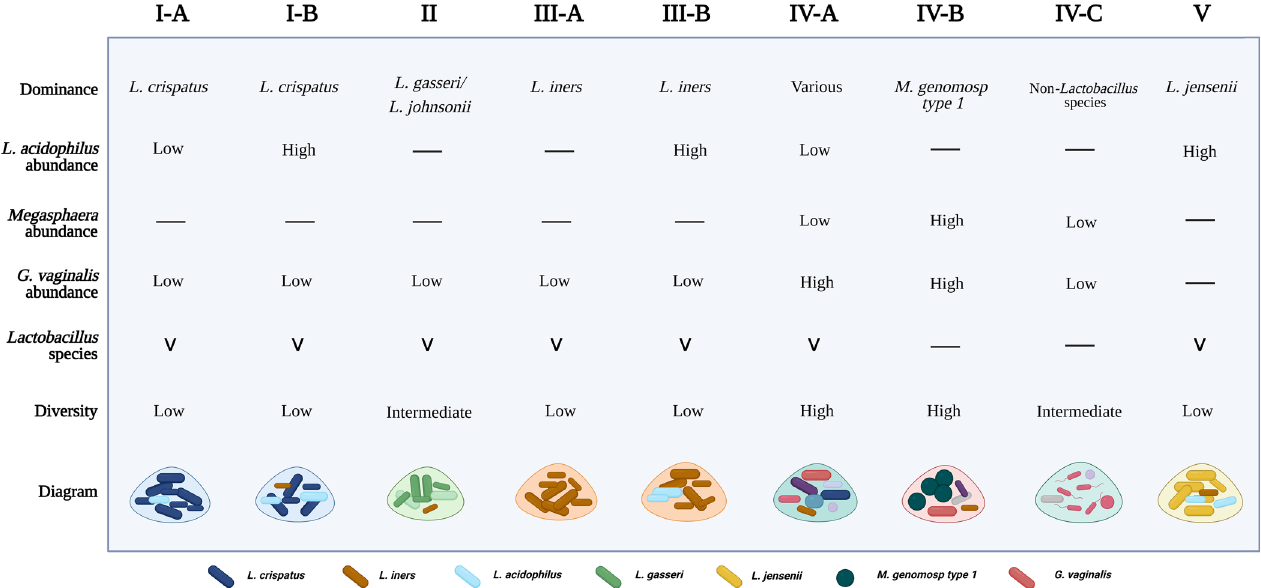
Fig. 4 Characteristics of novel cervicovaginal microbial community state types. CST I-A exhibits L. crispatus dominance, low abundance of L. acidophilus , and low diversity. CST I-B also possesses L. crispatus dominance but a higher abundance of L. acidophilus and L. iners . CST II retains L. gasseri/L. johnsonii dominance and has low diversity. CST III-A owns dominance for L. iners and shallow diversity. CST III-B is also characterized by L. iners dominance but includes L. acidophilus . CST IV-A displays dominance for various species, high abundance of G. vaginalis , and low abundance of M. genomosp type 1 . CST IV-B is characterized by dominance for M. genomosp type 1 , colonization by G. vaginalis , and Lactobacillus depletion (excluding L. iners ). CST IV-A and IV-B have a high diversity. CST IV-C is dominated by non- Lactobacillus species and exhibits Lactobacillus depletion with intermediate diversity. CST V has L. jensenii dominance, high abundance for L. acidophilus and L. iners , and overall low diversity. Presence of microbes is indicated by (V). Absence of microbes is indicated by ( − ). Non- Lactobacillus species and “ Various ” species that exhibit dominance in CSTs IV-A and IV-C, are listed in Supplementary Table 1. Created with BioRender.com.